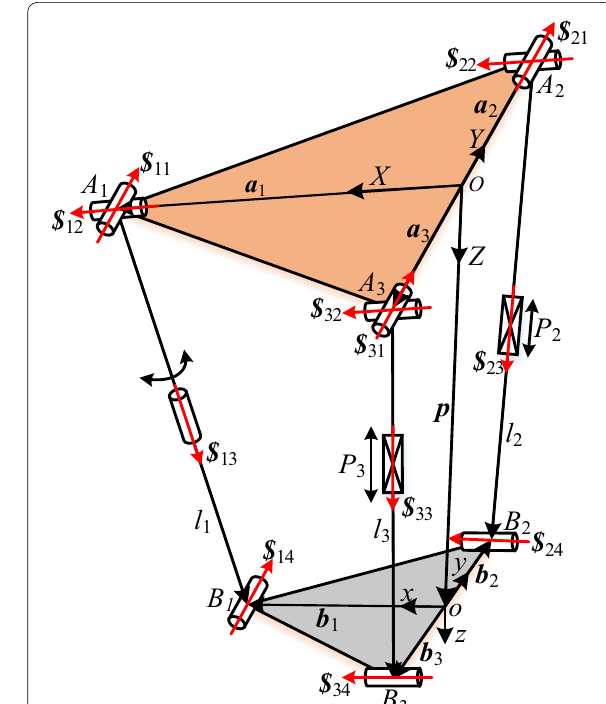
Figure 5 Diagram of 2-UPR/URR parallel